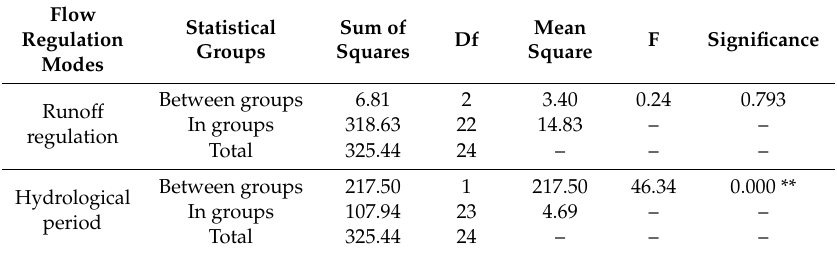
Table 6. One-way ANOVA results for macroinvertebrate abundance under two flow regulation modes in Qingyang River (QYR).